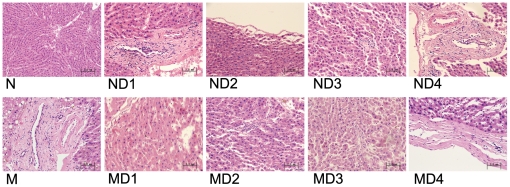
Typical histopathologic section photographs of rats in different groups (HE stained, 200× magnification).Dose-dependent vacuolar degeneration of the portal area and/or hyperplasia of the interstitial fibrous tissue were observed in the normal groups ND1–ND4. Obviously thickened envelopes and fibrosis of the portal area and/or stroma was observed in the animals of group M. This toxic degeneration caused by CCl4 was improved after treatment with rhubarb extract in groups MD1–MD4. Notably, alleviation of fibrosis of the liver envelope, portal area, and/or stroma was observed in the animals in the MD1 and MD2 groups, whereas aggravation of fibrosis was found in over 67% of animals in the MD3 and MD4 groups. N, normal rat group without treatment; ND1-ND4, normal rat groups treated with rhubarb extract at dosages of 2.00, 5.40, 14.69 and 40.00 g kg−1, respectively. M, model rat group without treatment; MD1-MD4, model rats groups treated with rhubarb extract at dosages of 2.00, 5.40, 14.69 and 40.00 g kg−1, respectively.